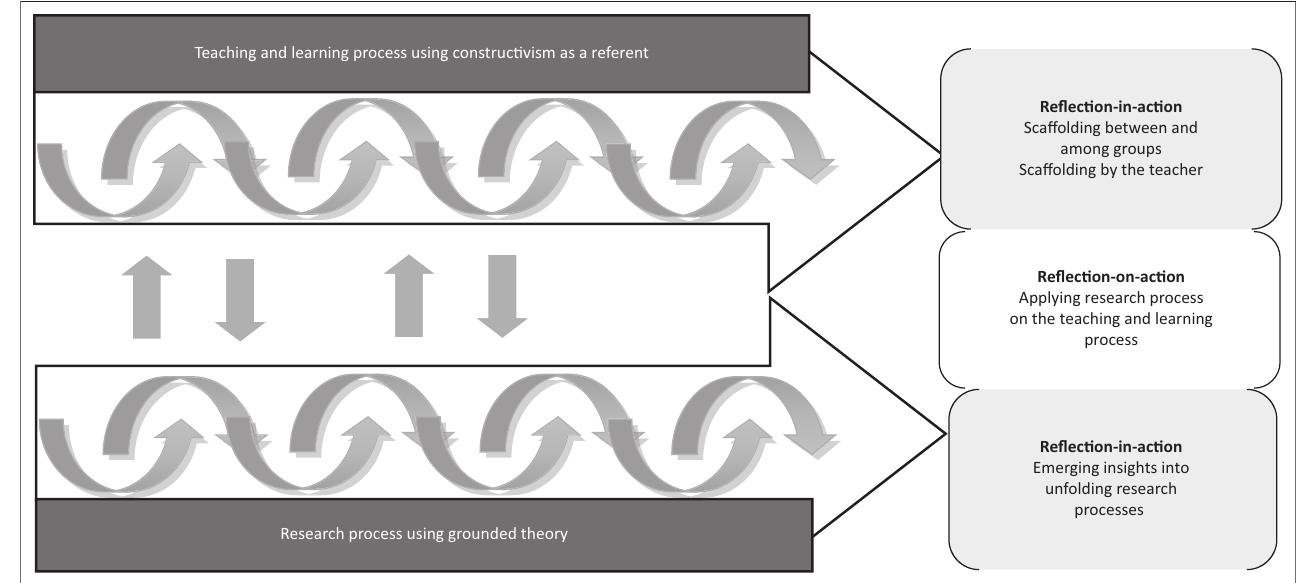
FIGURE 1: The emergent conceptual